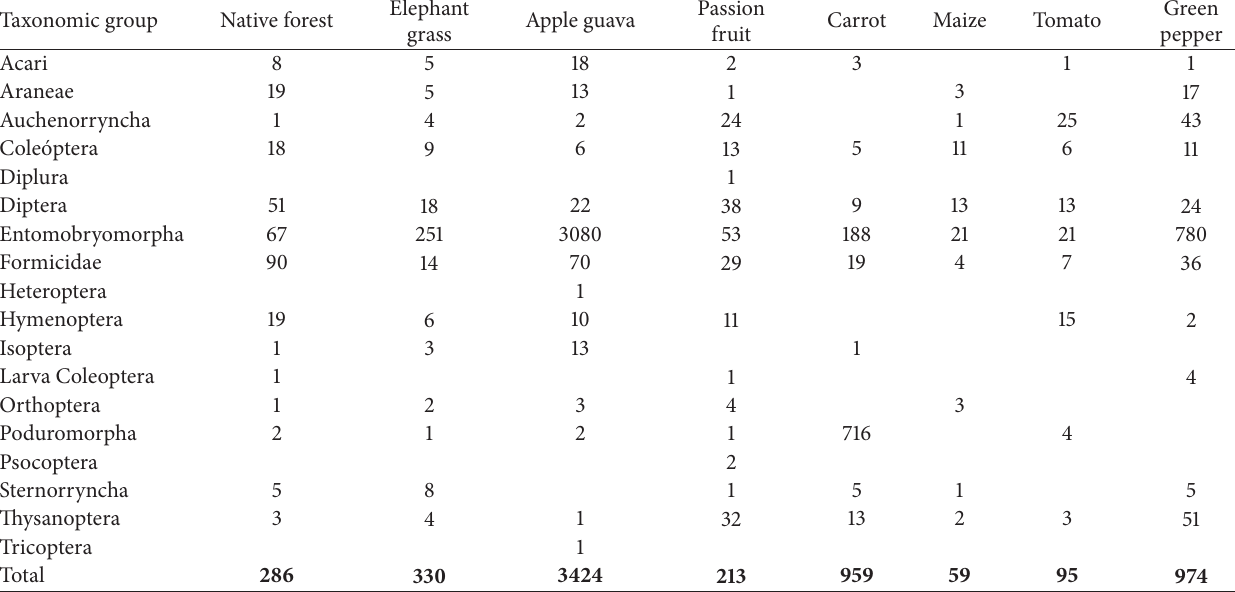
Table 4: Total number of individuals collected by 5 pitfall traps during a week for the taxonomic groups studied.